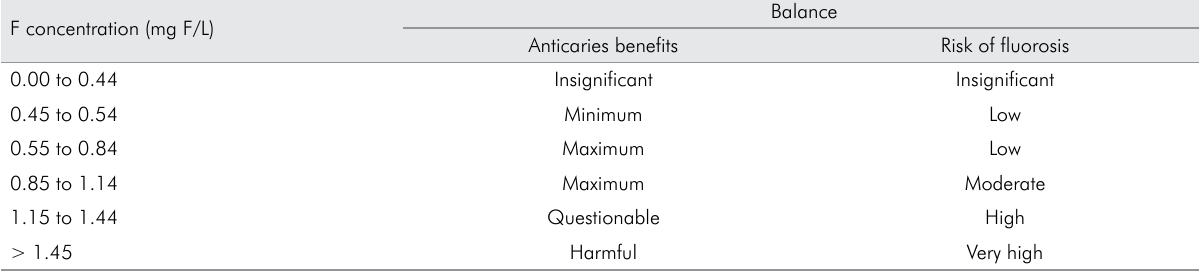
Table 1. Balance between anticaries benefit and risk of fluorosis expected according to the range of F concentrations in water for cities with maximum temperatures ranging from 26.3°C to 32.5°C.